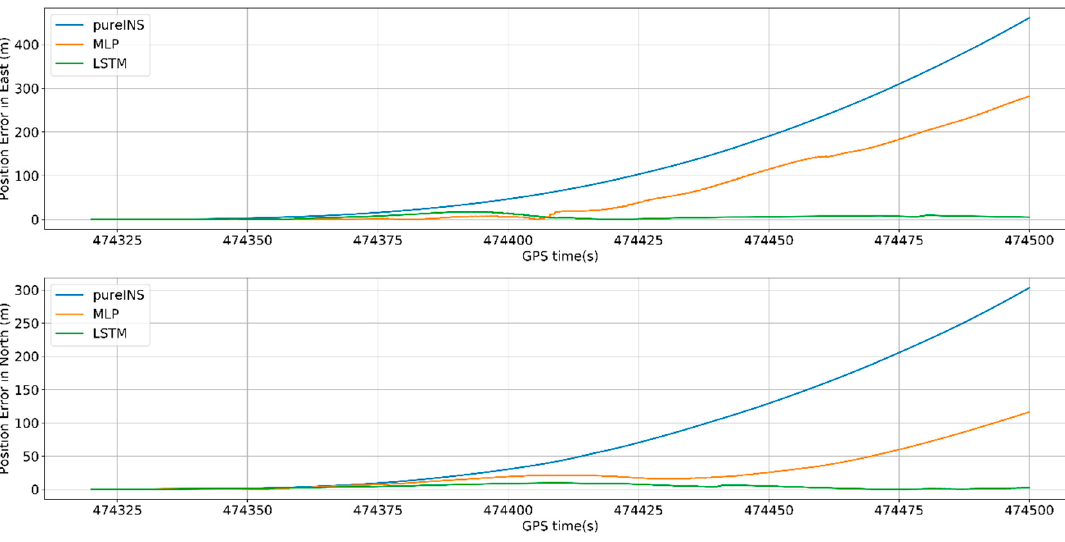
Table 7. Max error of position, velocity, and heading during 180 s GNSS outages in different algorithms. Figure 19. 120 s outages trajectory. Figure 19. 120 s outages trajectory.